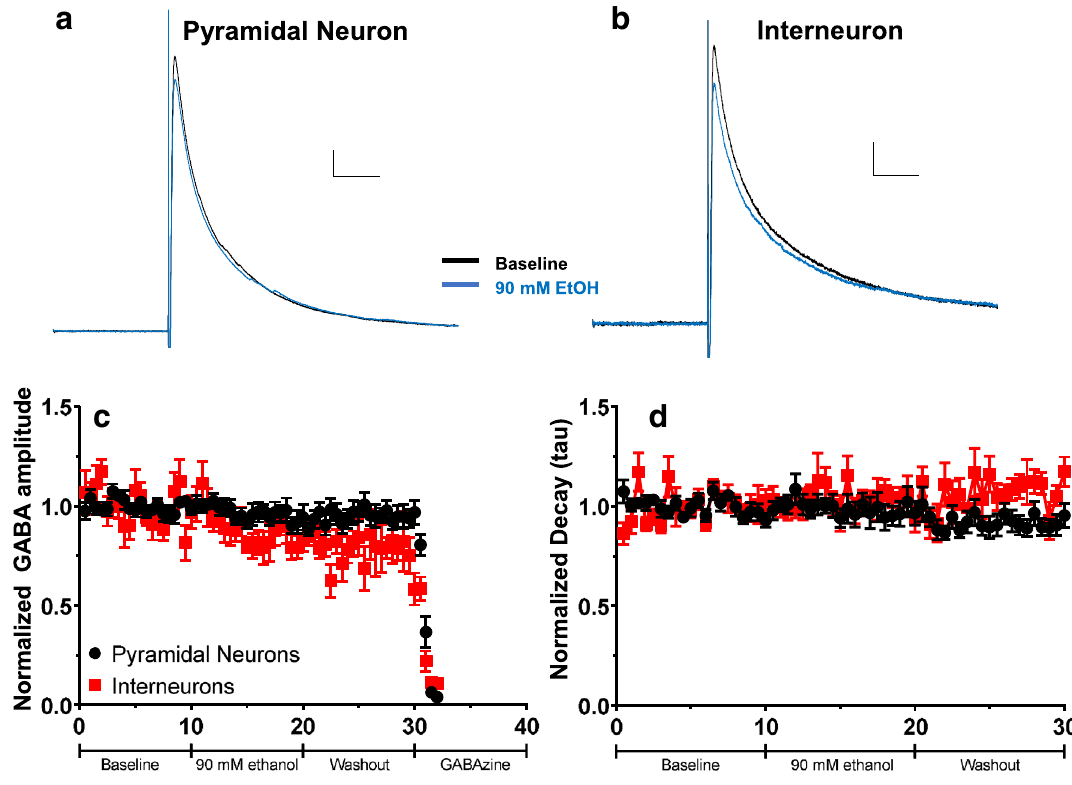
Figure 2. Effect of acute ethanol application on evoked GABA A receptor-mediated postsynaptic current (GABA A -ePSC) amplitude and decay in layer V pyramidal neurons and INs. ( a ) Average ePSC traces from layer V pyramidal neurons during the baseline (black trace) and acute 90 mM ethanol application (blue trace) phases. Scale bars 40 ms, 50 pA. ( b ) Average ePSC traces from layer V INs during the baseline and acute 90 mM ethanol application phases. Scale bars 40 ms, 20 pA. ( c ) Normalized GABA A -ePSC amplitudes for both pyramidal neurons (black circles) and INs (red squares) in layer V during the baseline, 90 mM ethanol application, washout, and gabazine (25 µM) application phases. ( d ) Normalized decay constants (tau) for both pyramidal neurons and INs during the baseline, 90 mM ethanol application and washout phases. Data are presented as mean ±